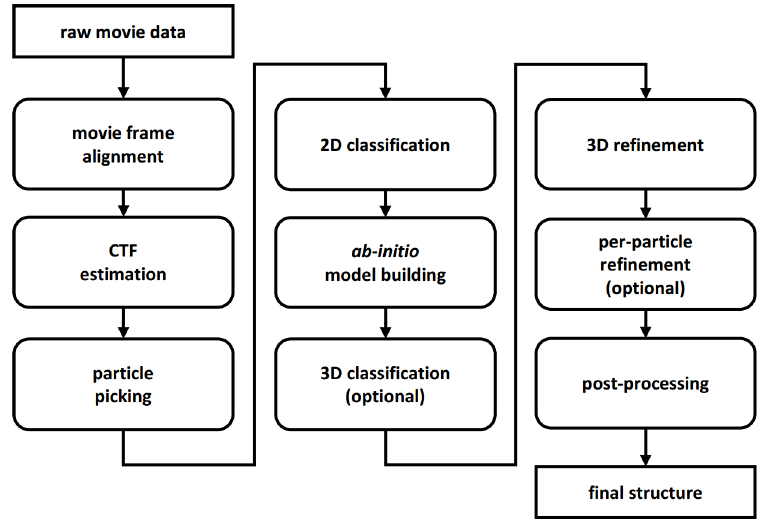
Figure 1. Typical steps of the Single Particle Analysis processing pipeline